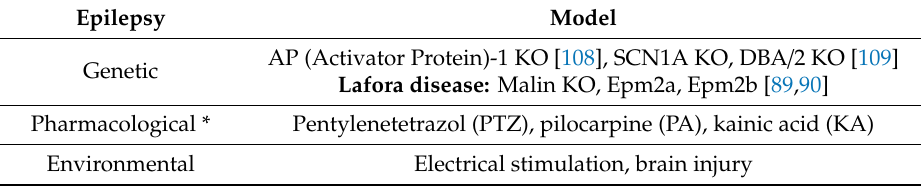
Table 3. Epilepsy models with observed neuron-glia